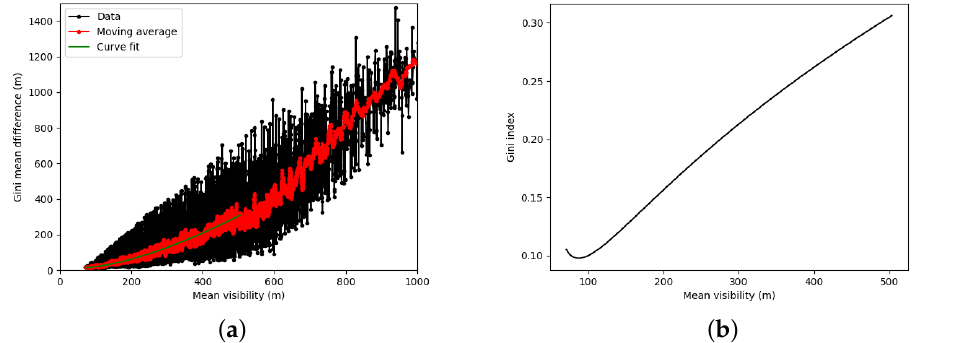
Figure 8. ( a ) Mean difference E , (cid:98) E and ˜ E as functions of the mean visibility M ; ( b ) modelled Gini ˜ G as a function of mean visibility M